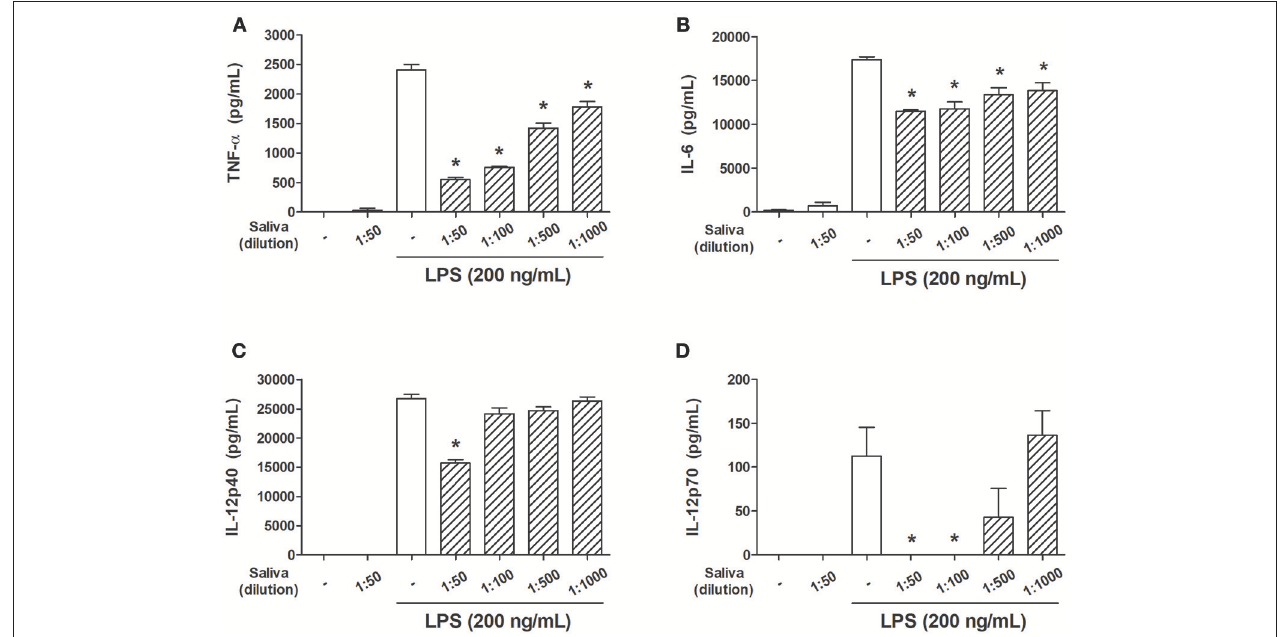
FIGURE 1 | A. sculptum saliva inhibits the production of inflammatory cytokines by LPS-stimulated murine DCs. Bone marrow cells from C3H/HePas mice were differentiated into DCs, seeded at 10 5 cells/well in 96-well plates and preincubated for 1h with medium only or with different dilutions of A. sculptum saliva (indicated in the figure) collected by pilocarpine stimulation from female ticks fed on host for 7–9 days. Cells were stimulated with ultrapure LPS (200ng/mL) during 6h for TNF- α (A) or 18h for IL-6, IL-12p40, and IL-12p70 (B–D, respectively) determination in culture supernatants by ELISA. Results are expressed as the mean ± SEM. * p ≤ 0.05 vs. “LPS without saliva” group.